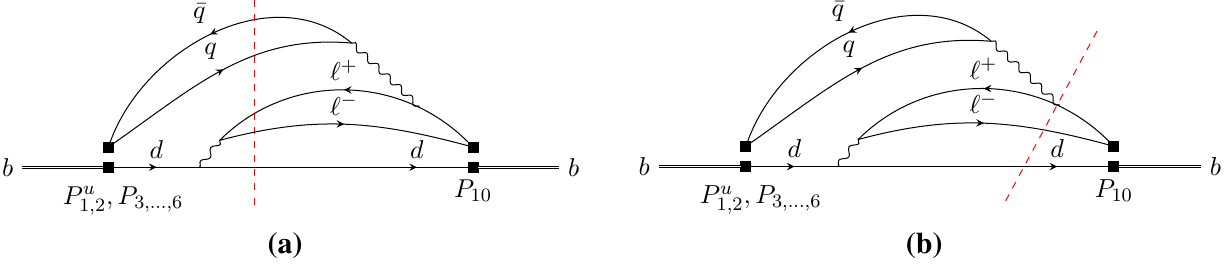
, P ¯ q -pair is emitted from the charged leptons. The cancellation of infrared Fig. 3 Illustration of the P u 3 ,..., 6 interference with P 10 where the q 1 , 2 divergences in the five-particle cuts ( a ) requires fewer-particle cuts involving loops as exemplified in ( b